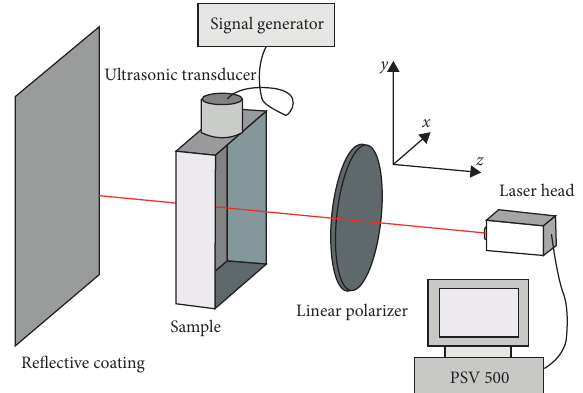
Figure 8: Two-dimensional dynamic stress experiment setup based on LDV